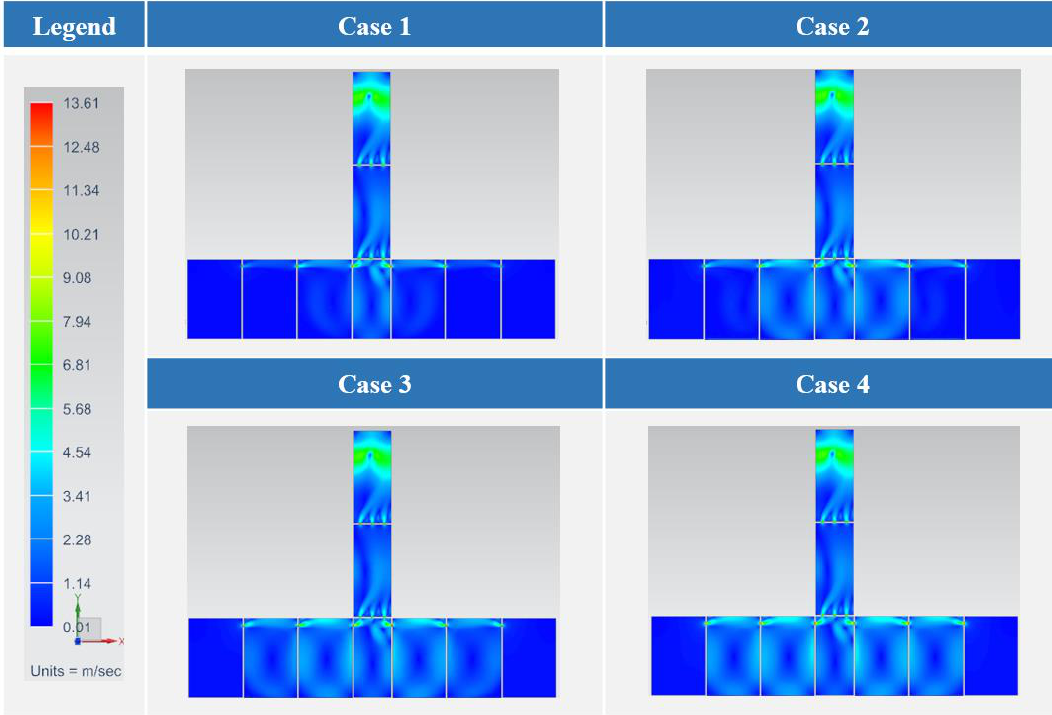
Figure 8. Velocity distribution in an air-type BIPVT